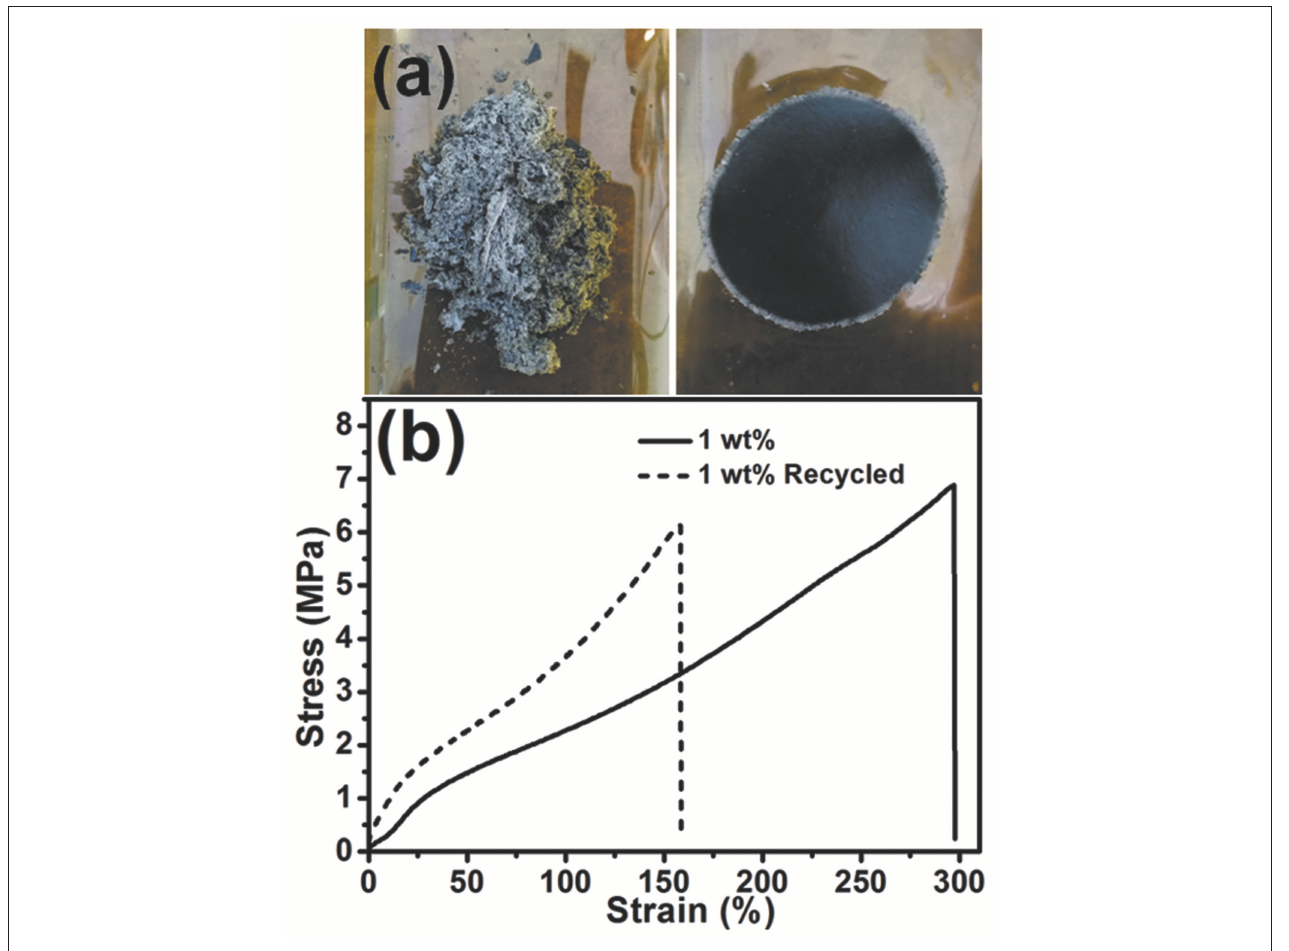
FIGURE 8 | (a) Photographs of grinded and recycled hGnP/epoxy with 1 wt% GnP. (b) Typical stress-strain curves of original and recycled hGnP/epoxy with 1 wt% GnP.